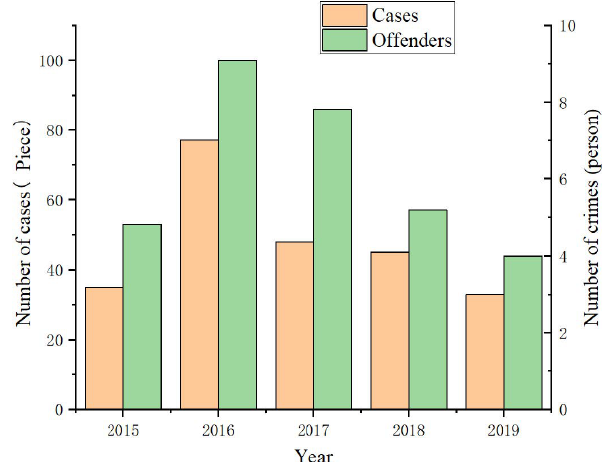
Fig. 3 Statistics of campus crime in a determinate